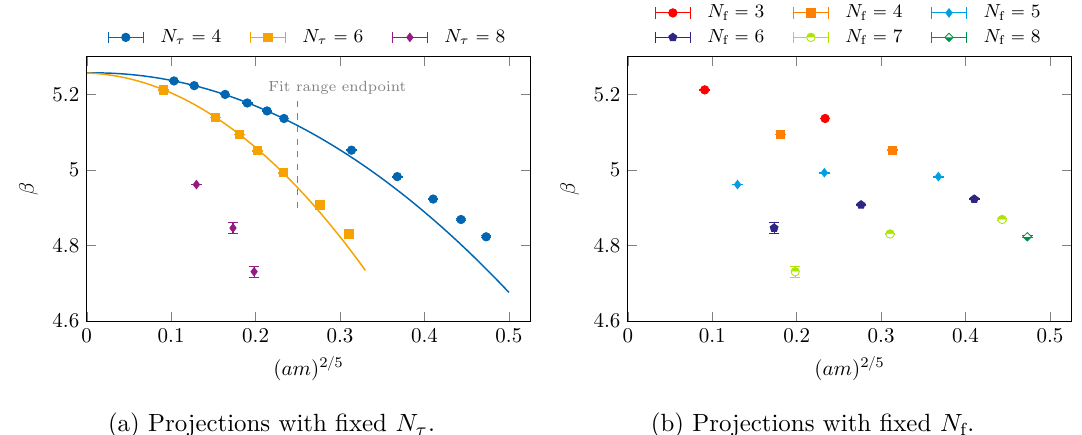
Figure 6. The chiral critical surface, separating 3D parameter regions with a first-order transition from crossover regions, projected onto the ( β, am ) -plane. Every point represents a phase boundary with an implicitly tuned β c ( am, N f , N τ ) . In (a) the lines represent next-to-leading order fits in the scaling variable, cf. table